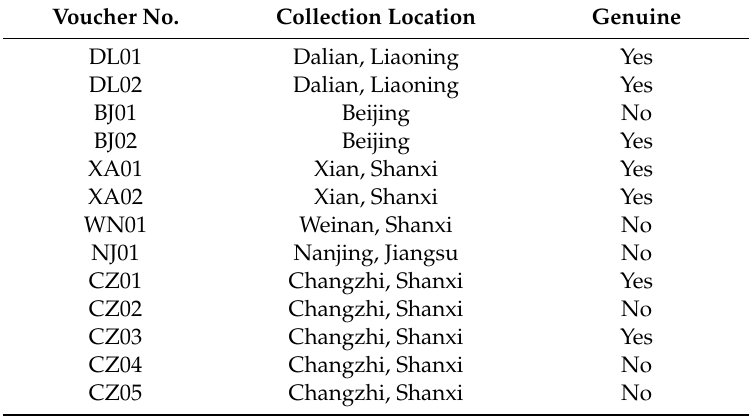
Table 1. Characteristics and identification results of commercial crude drug samples labeled as Schisandrae Chinensis Fructus